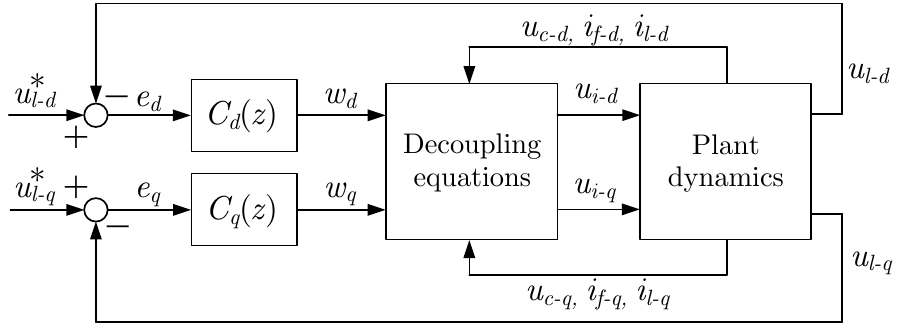
Figure 3. Overview of the control strategy for a DVR. Two independent controllers are used.